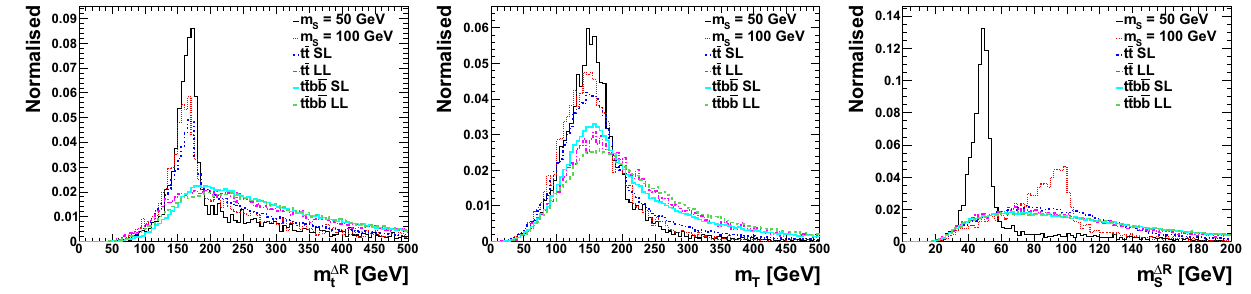
Fig. 1 (Left) The reconstructed top mass from the closest b -pair. (Center) The transverse mass m T . (Right) The reconstructed mass of the scalar S Table 2 Efficiency after each cut for the six signal benchmark points